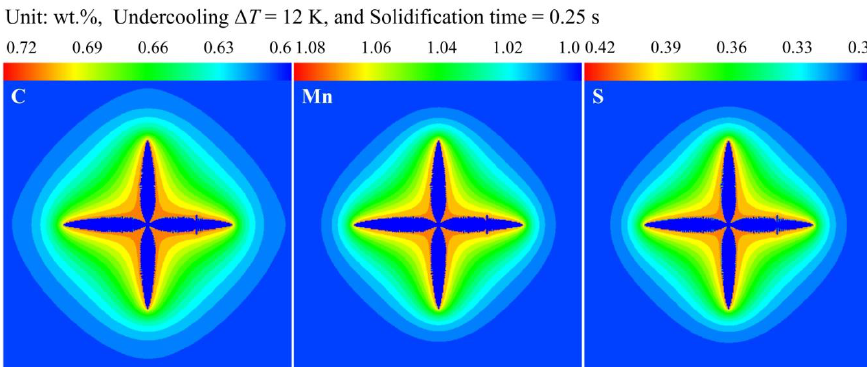
Figure 3. Solutal concentration and morphology of growing dendrites.